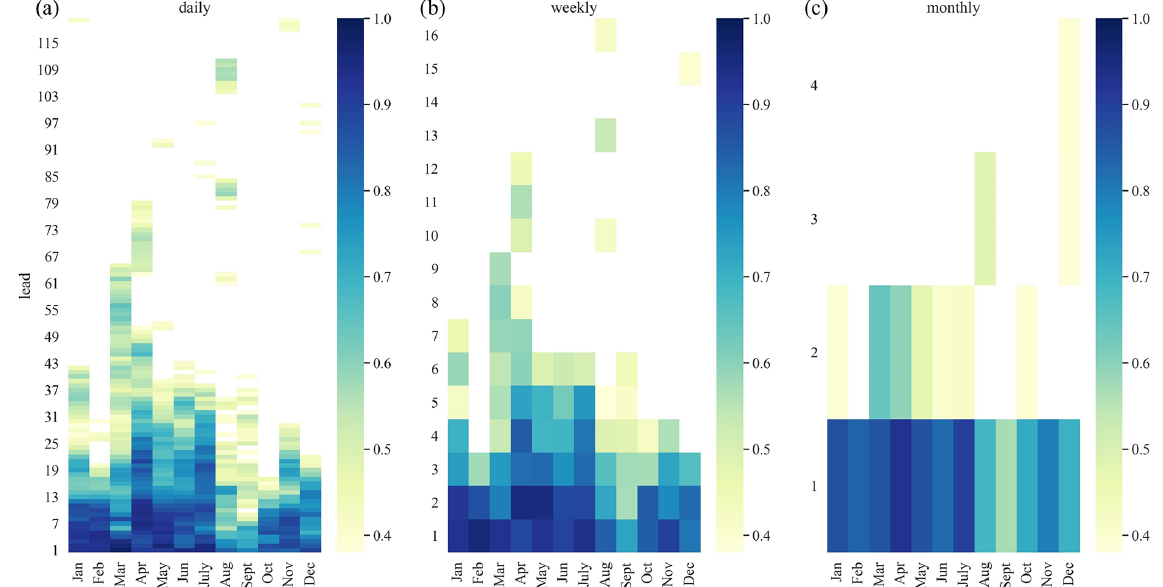
Figure 6. ACC results for the discharge hindcasts using the RF model of station Hagenstein Boven over different temporal scales – (a) daily, (b) weekly, and (c) monthly – and different initialization months. Only significant values are shown (indicated by a range of 0.4 and higher).